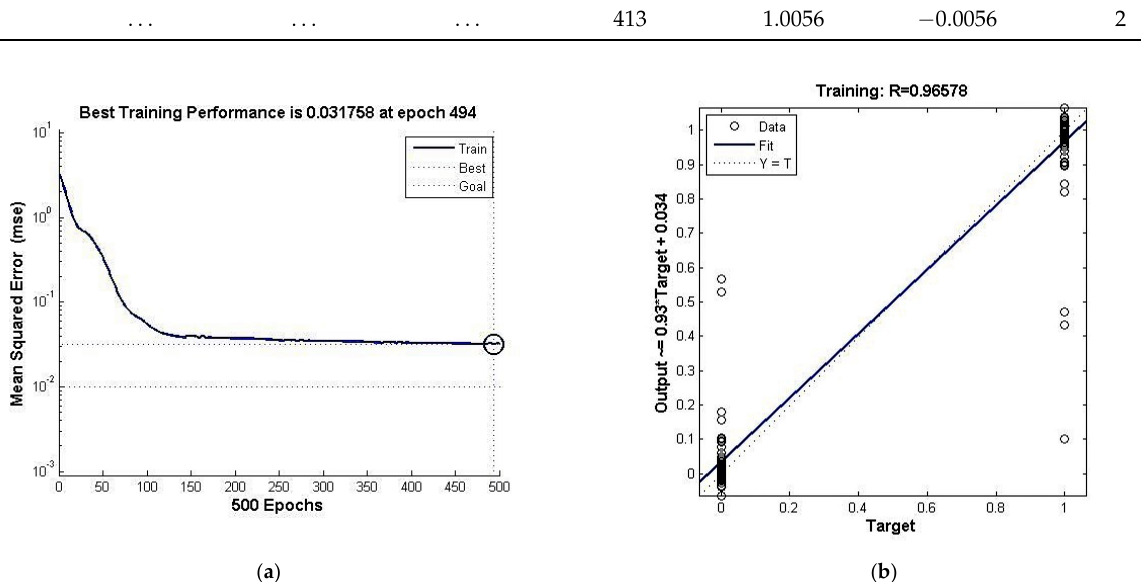
Figure 5. MSE of training and correlation coefficient diagram. ( a ) Image of the effect of epoch on mean square error; ( b ) Regression equation image of output data.